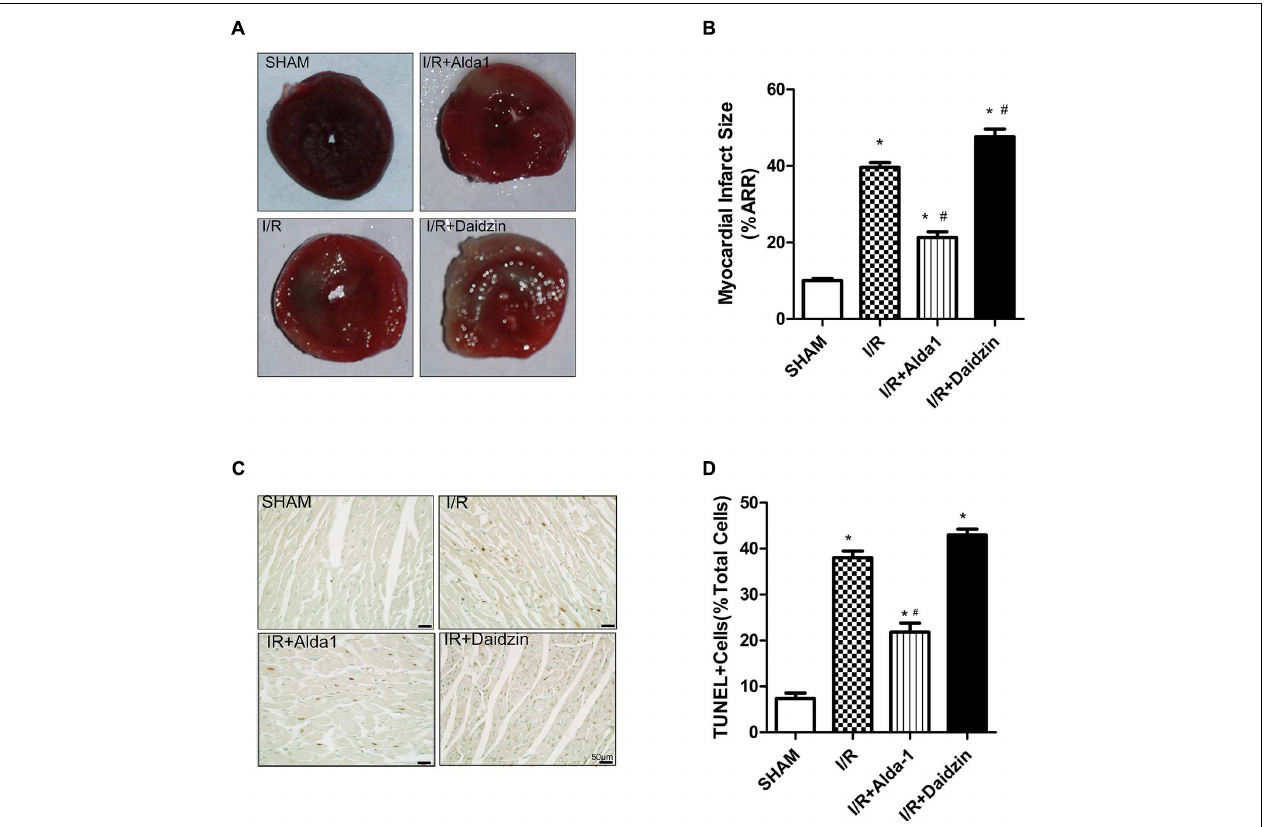
FIGURE 1 | Myocardial infarct size and cardiomyocytes apoptosis in I/R rats. (A) TTC staining for myocardial infarct size with representative tissue sectioning for SHAM, I/R, I/R + Alda-1, the ALDH2 activator, and Daidzin, the inhibitor. (B) The infarct size was expressed as a percentage of area at risk ( P < 0.0001, One-way ANOVA). (C) TUNEL staining for myocardial tissue apoptosis. (D) Ratio of apoptosis ( P < 0.0001, One-way ANOVA). n = 3/group. Representative TUNEL staining images are shown (magnification, 200 × ). Scale bar: 50 µ m. Data are mean ± SD from 3 independent experiments. ∗ P < 0.05 vs. sham; # P < 0.05 vs.